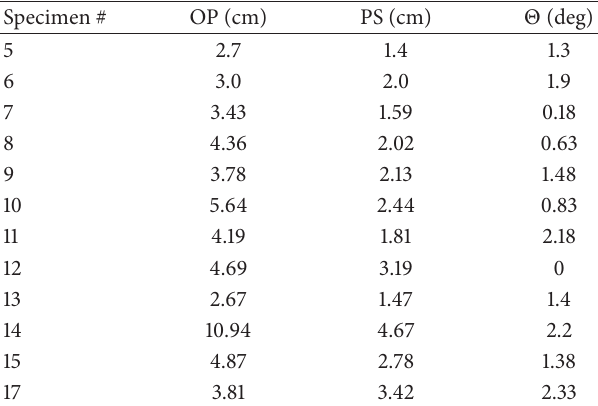
Table 1: Values of Θ and the means of OP and PS. Specimen